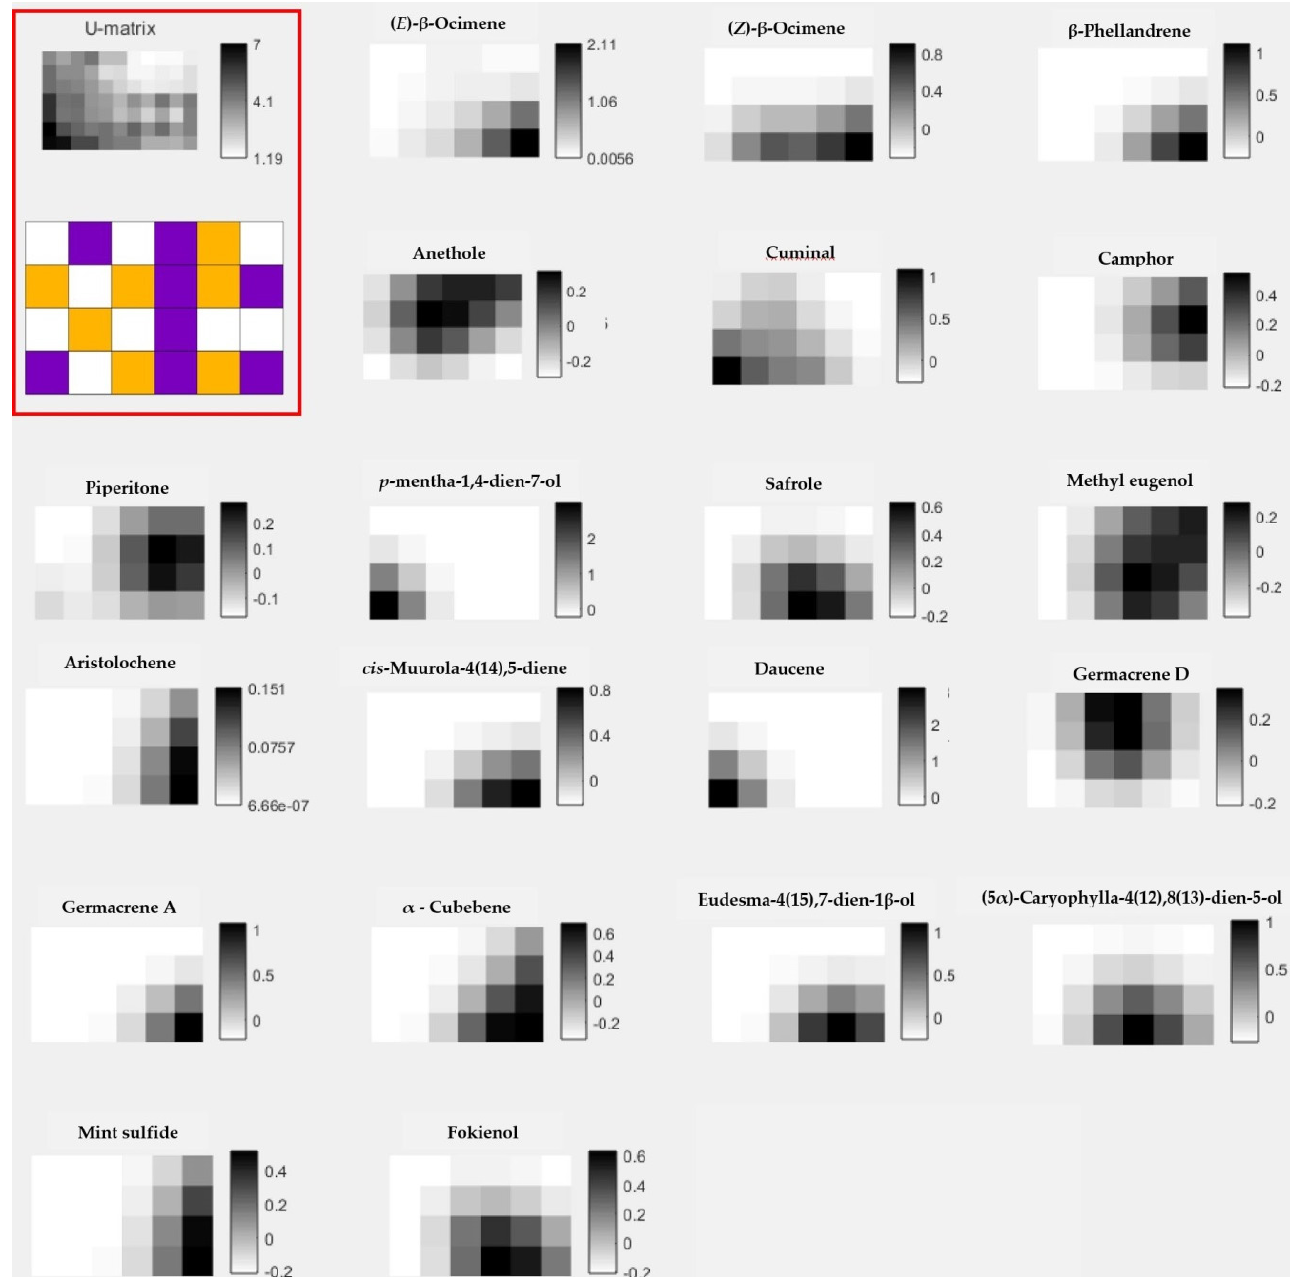
Figure 3. The most significant molecules for the EOs by activity. In the upper left we have the U-matrix of the self-organizing map generated in the study, with the upper U-matrix not identifying the tribes and the lower U-matrix identifying the tribes by color; active is violet and yellow represents samples with no antiprotozoal activity or that have not been reported.